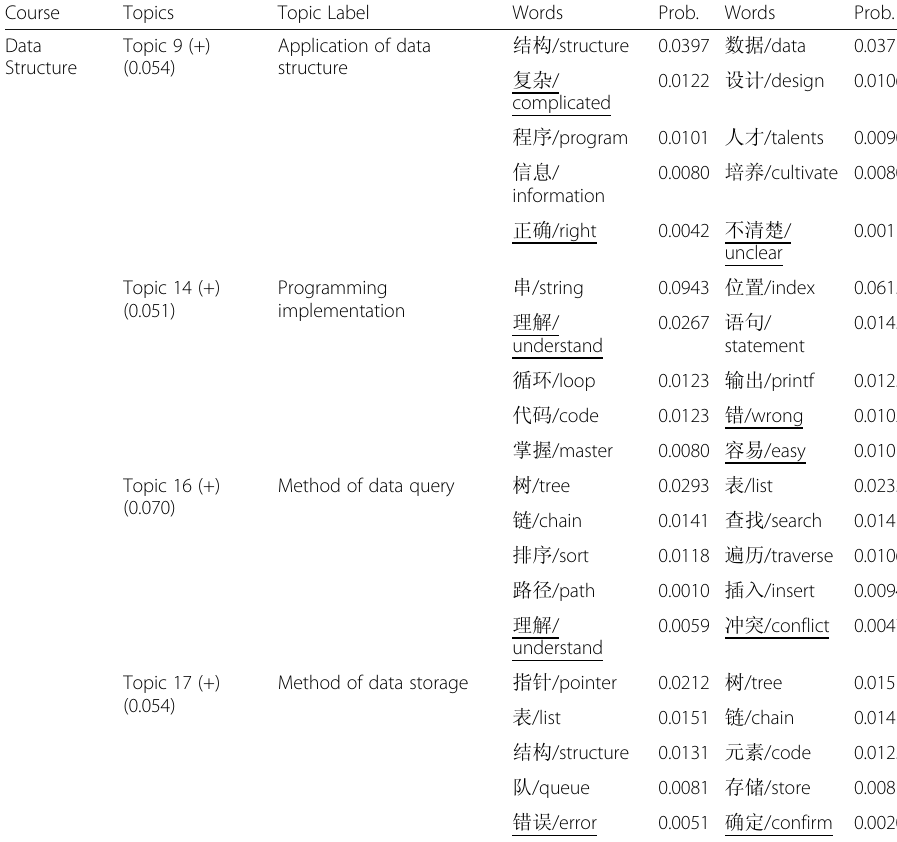
Table 4 Examples of four typical topics and their probabilities over words in the Data Structure course. These representative words, including topic words (not underlined) and emotion words (underlined) have higher probabilities. (+) denotes that the topic ’ s overall emotion is positive. The probability value below (+) represents the average probability of each topic appearing in the next semester of the